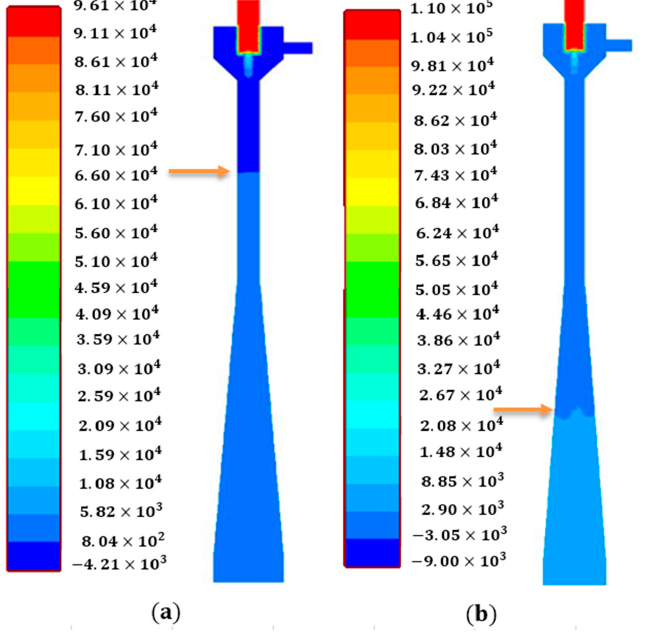
Figure 12. The influence of the mass flow rate on the mixing shock phenomenon, ( a ) flow rate: 2.49 × 10 − 4 m 3 /s, ( b ) flow rate: 2.64 × 10 − 4 m 3